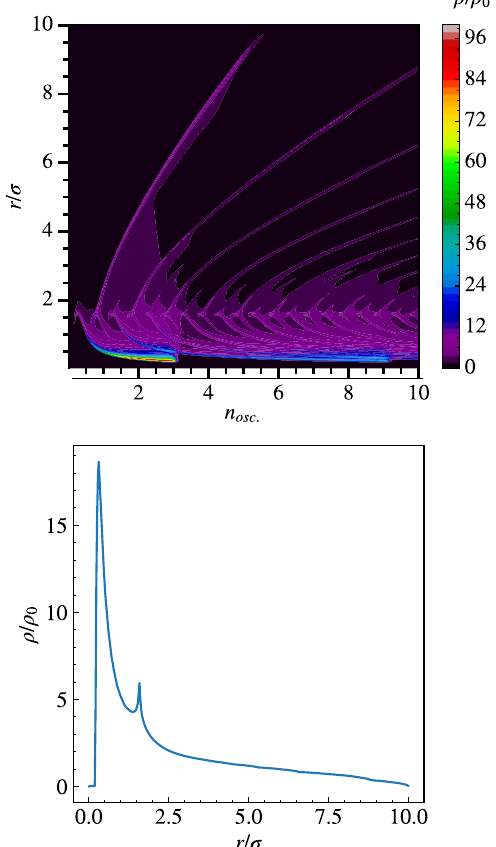
FIG. 17. EDM molecule density as a function of the radius and “ time ” (top) and the end time-averaged local molecule density versus radius (bottom). The molecule density is normalized with respect to the initial (or space-averaged) molecule density. The molecules are cold T=T (cid:3) p ¼ 10 − 5 . In this simulation, the particles were distributed throughout the transverse x - y space. At the bottom, the large peak of density is ∼ 20 times the initial uniform distribution. Note the smaller peak of density, which reflects the local oscillations of molecules around the equilibrium radius r= σ ≃ π = 2 ; this phe- nomenon is clearly visible in the top panel as